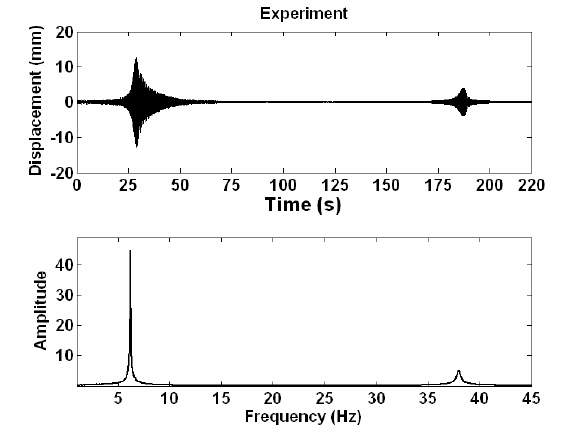
Fig. 6. Experimental results on time and frequency domain in Case 1.